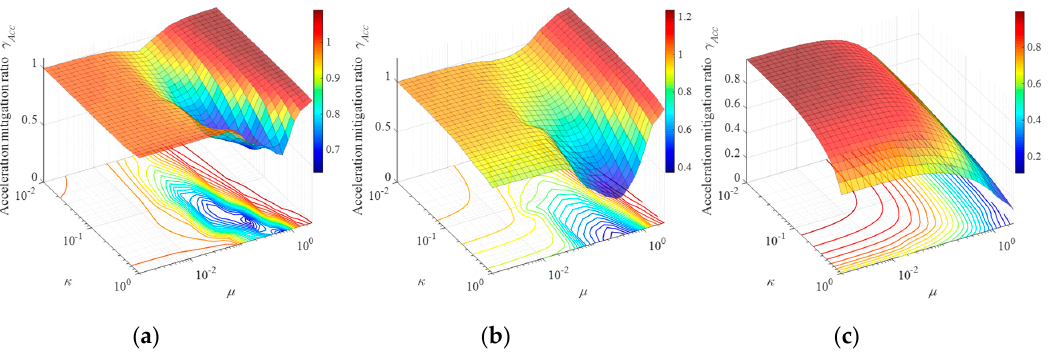
Figure 7. Variation of γ Acc for: ( a ) λ = 0.2, ( b ) λ = 1.00, and ( c ) λ = 1000.